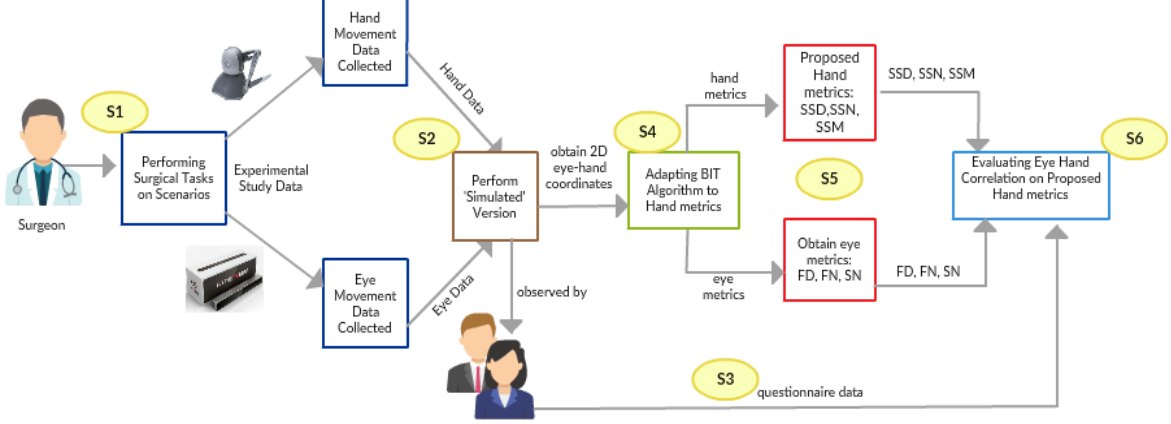
Figure 4. Procedure of the Experimental